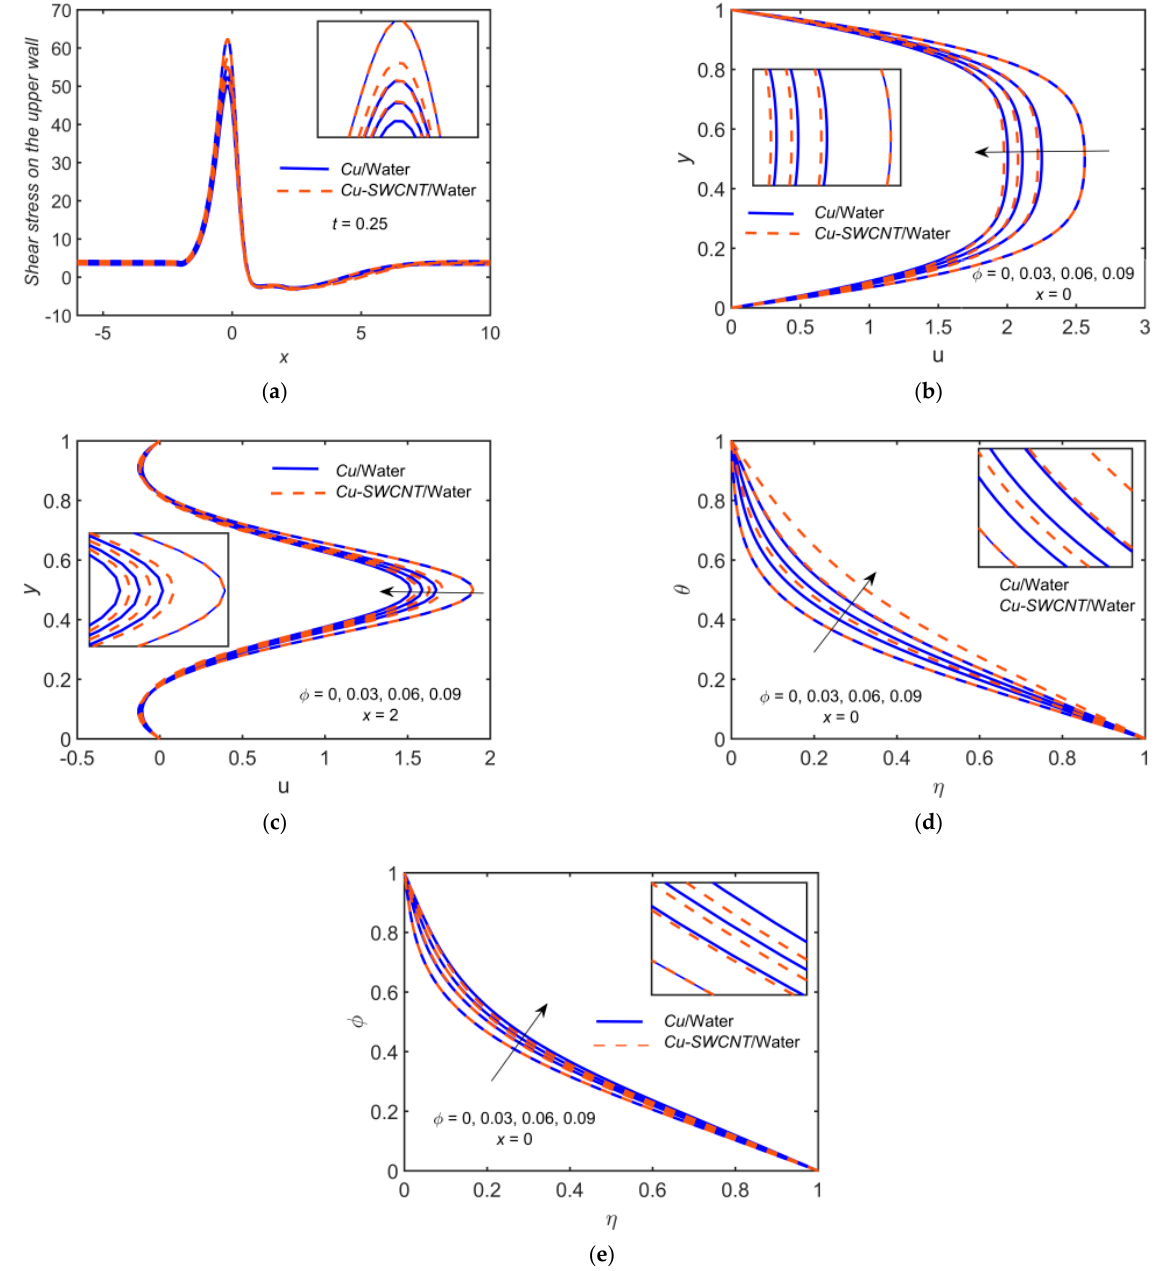
Figure 10. ( a ) The WSS distribution, ( b ) 𝑢 profile at 𝑥 = 0 , ( c ) 𝑢 profile at 𝑥 = 2 , ( d ) 𝜃 profile at 𝑥 = 0 , and ( e ) 𝜑 profile at 𝑥 = 0 for distinct values of 𝜙 . x = 0 for distinct values of φ